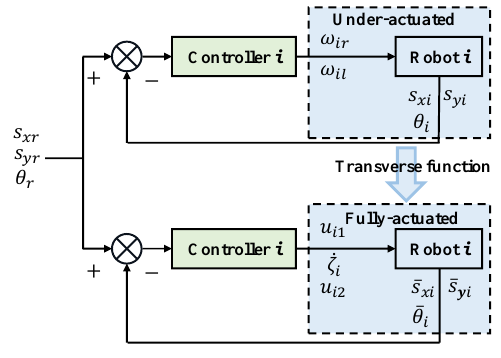
Figure 2. The under-actuated system is transformed into a fully-actuated